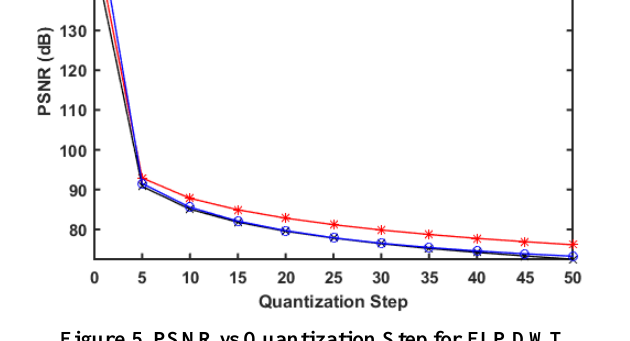
Figure 5. PSNR vs Quantization Step for FLP DWT.